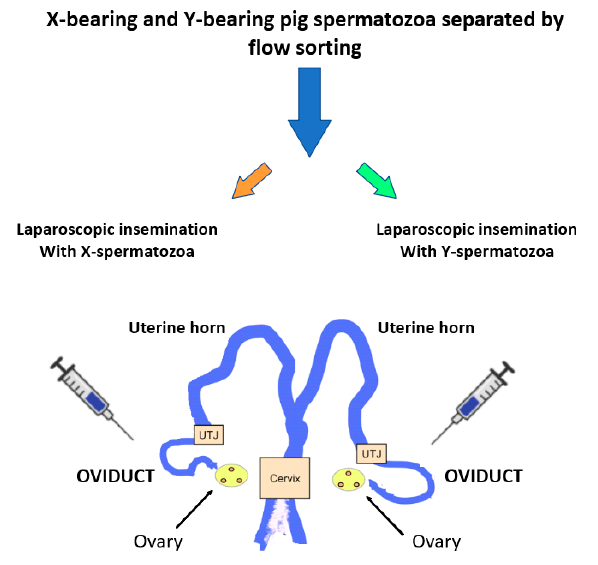
Figure 2. Schematic diagram showing the method used to establish that the oviducts can distinguish between X- and Y-chromosome-bearing spermatozoa.